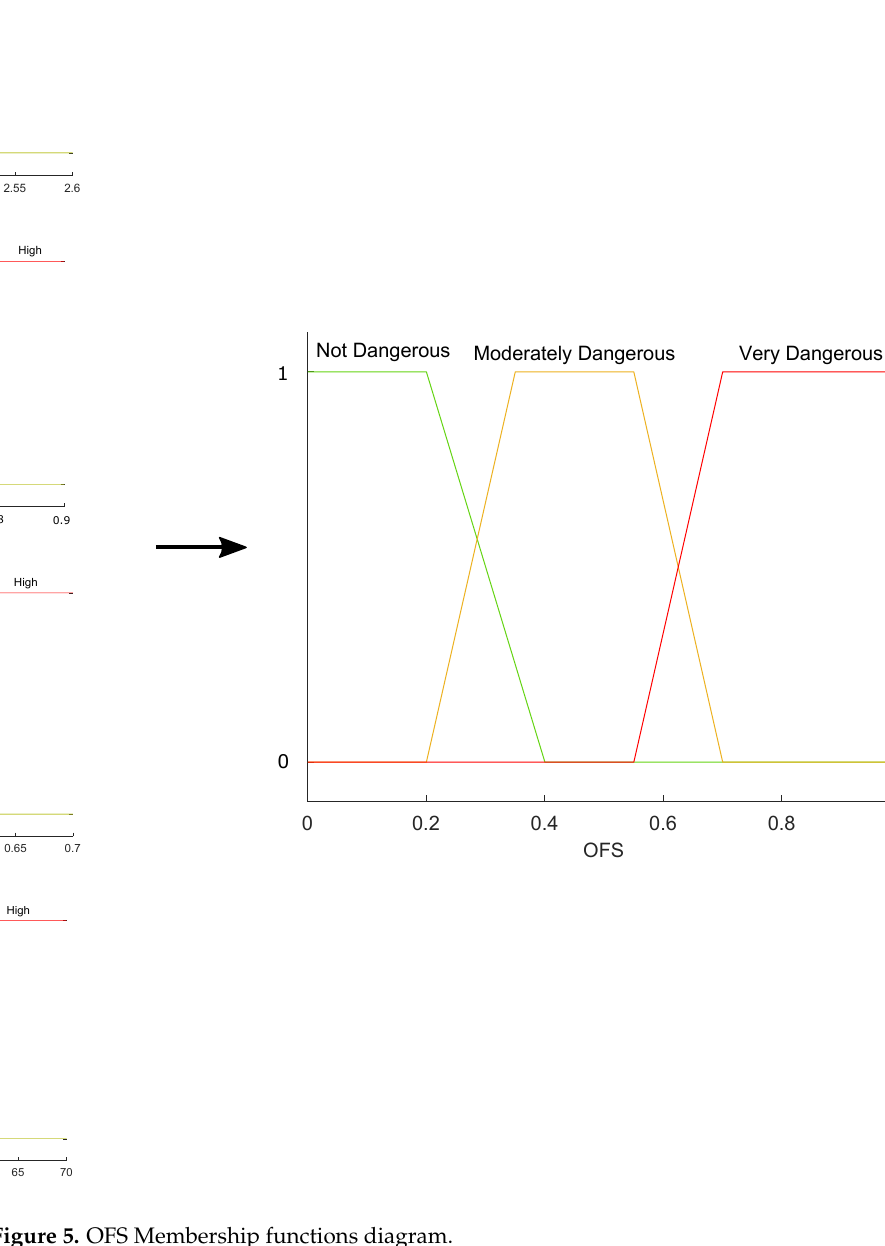
Figure 5. OFS Membership functions